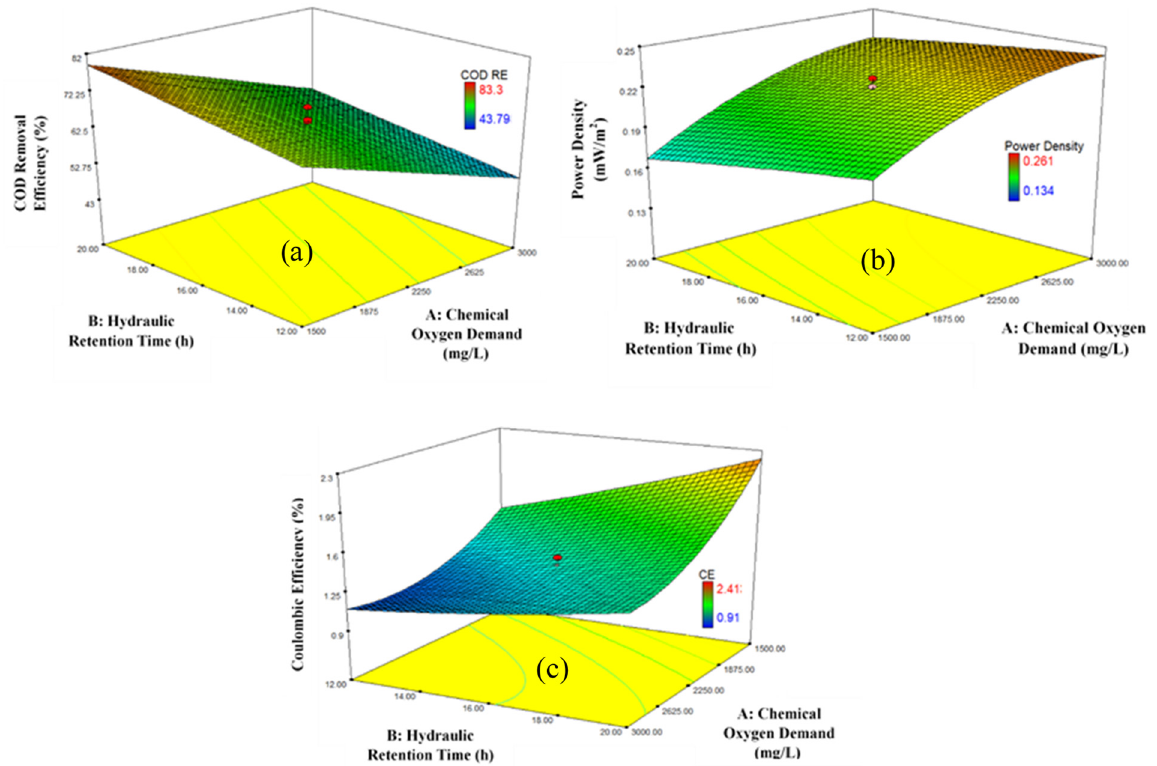
Figure 5. The 3D response surface curves for COD removal ( a ), PD ( b ), and CE ( c ) for two factors, COD and HRT with respect to AESA (24 cm 2 ).